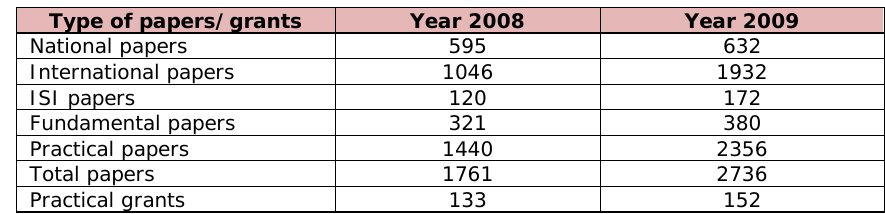
Table 1. “Research in Transilvania University of Braşov”. Source: GESFO,